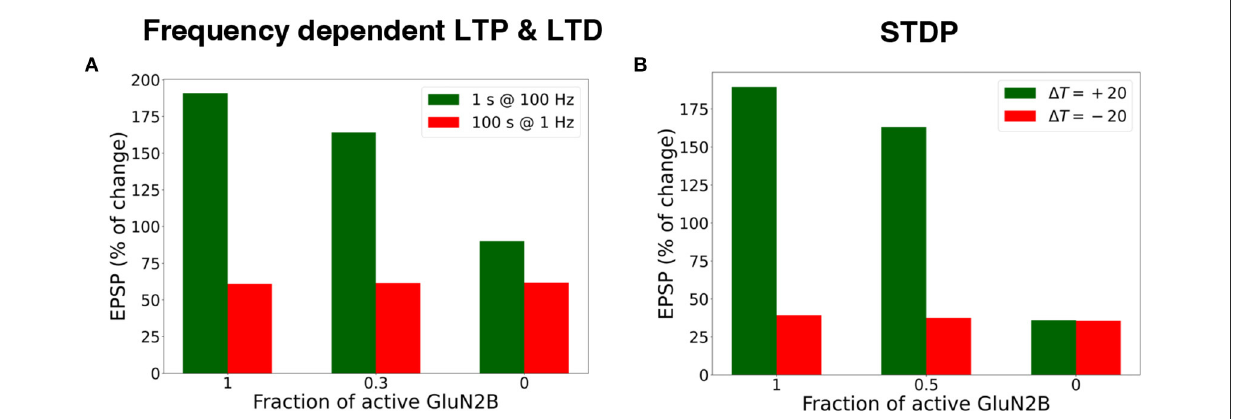
FIGURE7 Blockade of GluN2B-NMDAR prevents LTP for high-frequency and STDP stimulation protocols. (A) Presynaptic input was stimulated at 100 Hz for 1 s (LTP protocol, green bars) and at 1 Hz for 100 s (LTD protocol, red bars). LTP was impaired, and LTD remained intact. (B) Presynaptic activity was paired with a doublet of postsynaptic action potentials 60 times at 5 Hz frequency with a temporal difference 1 T = +20 ms (LTP protocol, green bars) and 1 T = -20 ms (LTD protocol, red bars). LTP was abolished, and LTD was